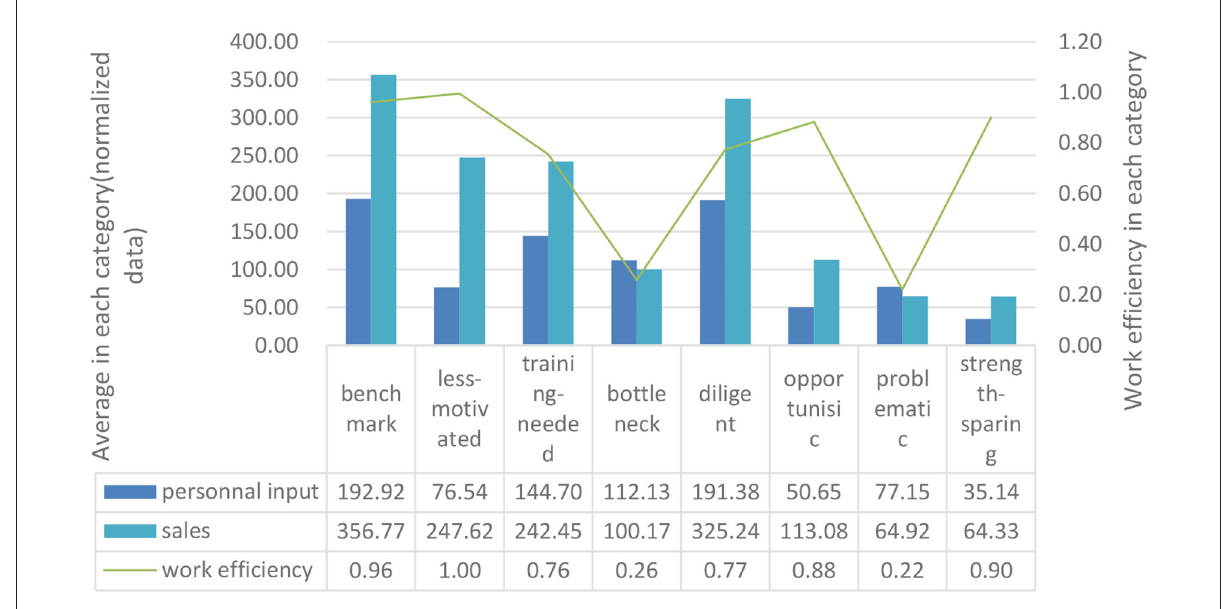
FIGURE3 Average personnel input, work efficiency and sales in each type of